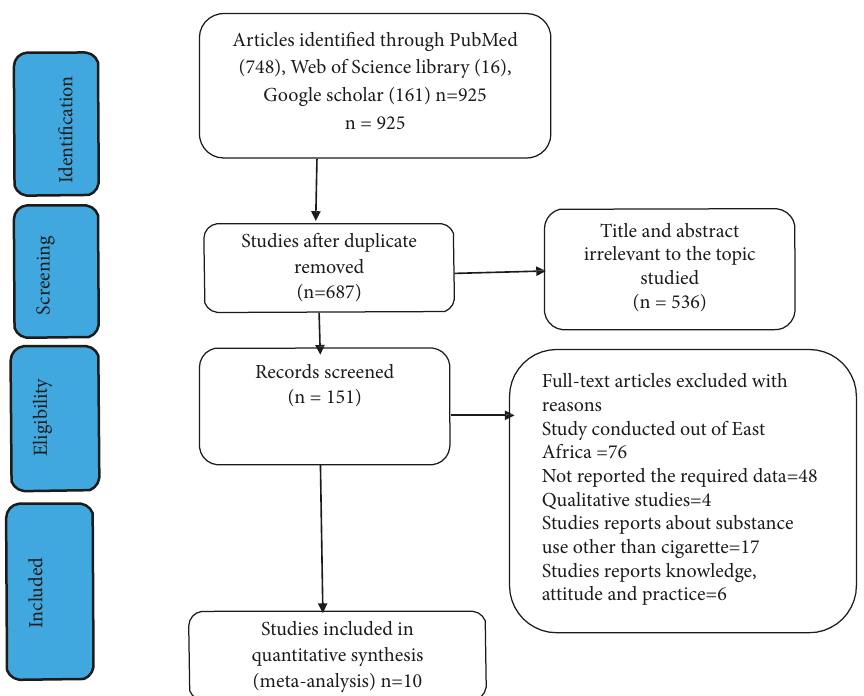
Figure 1: PRISMA flow diagram of identification and selection of studies for this systematic review and meta-analysis.